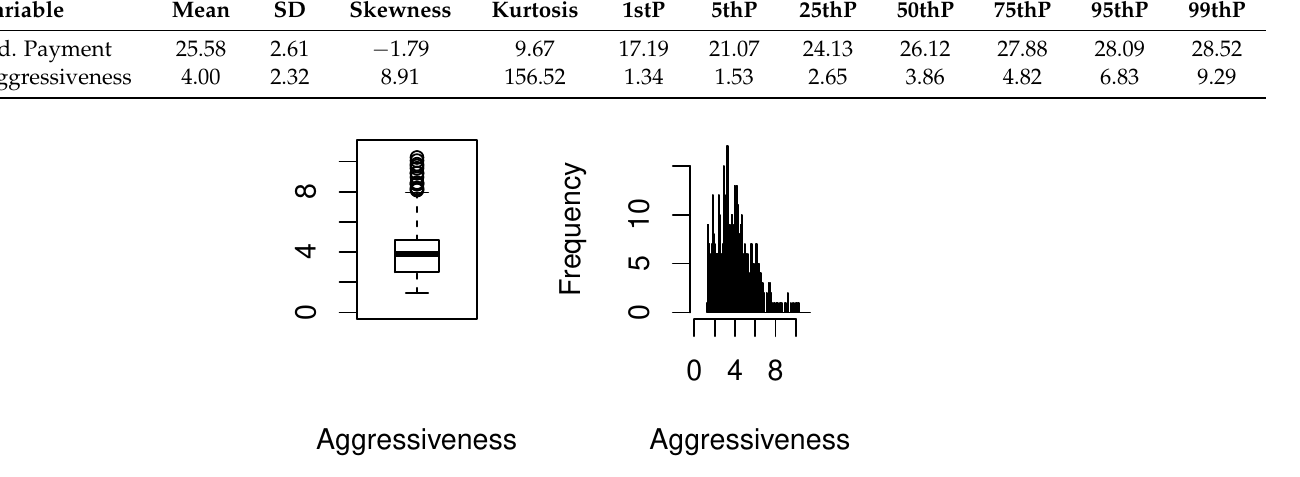
Table 1. Summary statistics for Average Standardized (Std) Payment Amounts and Aggressiveness for Procedure 77055. Variable